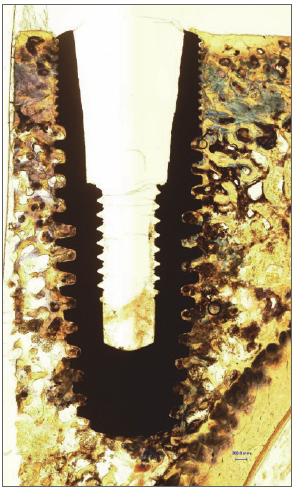
Fig. 1. Implantation system PV I. Fig. 2. Section of the tibia bone with the PV I. implant in a